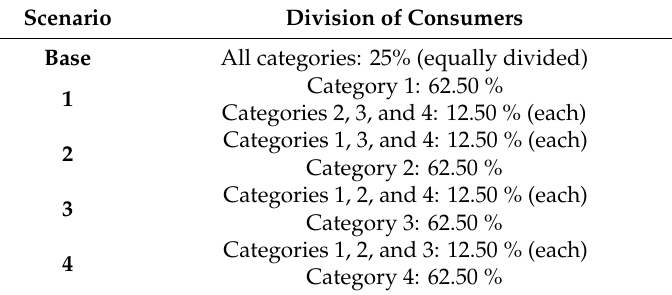
Table 2. Simulation